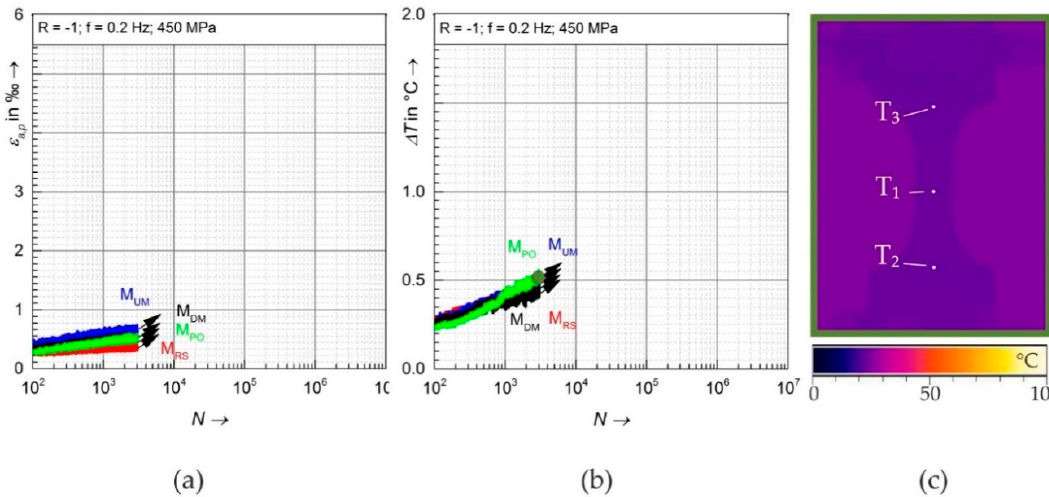
Figure 11. Stress-controlled single step tests at 450 MPa, f = 0.2 Hz: ( a ) development of plastic strain amplitude ( ε a,p ) vs. number of cycles ( N ); ( b ) development of temperature change ( ∆ T ) vs. number of cycles ( N ); ( c ) distribution of temperature on a specimen with morphology M PO at N = 3000.